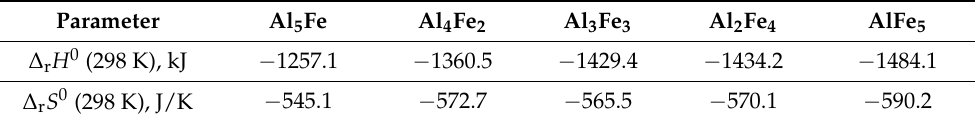
Table 13. Calculated values of the parameters ∆ r H 0 (298 K) and ∆ r S 0 (298 K) for the Reactions (1)–(5). Parameter